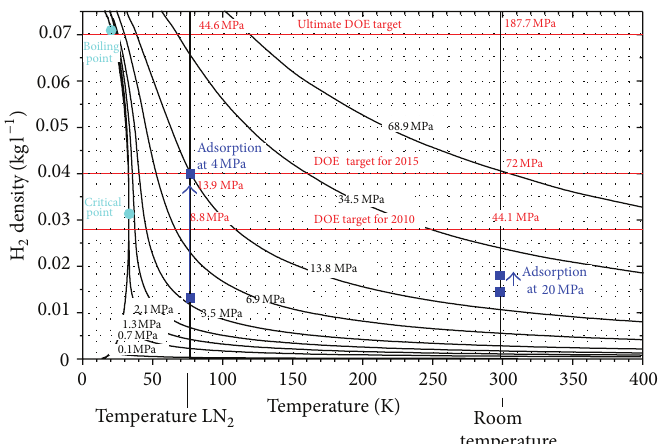
Figure 8: Density diagram for hydrogen, including the DOE targets for volumetric storage density. Thermo-physical data was obtained from NIST